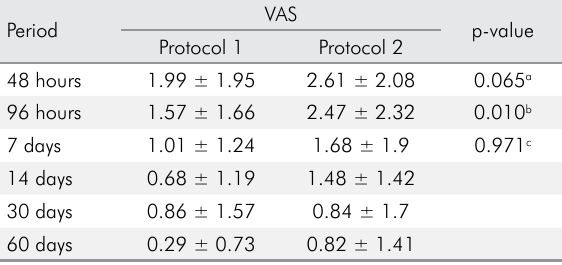
Mean ± Standard deviation. a p-value for treatment effect using analysis of variance (ANOVA); b p-value for time influence using analysis of variance (ANOVA); c p-value for the effect of treatment vs. time using analysis of variance (ANOVA).